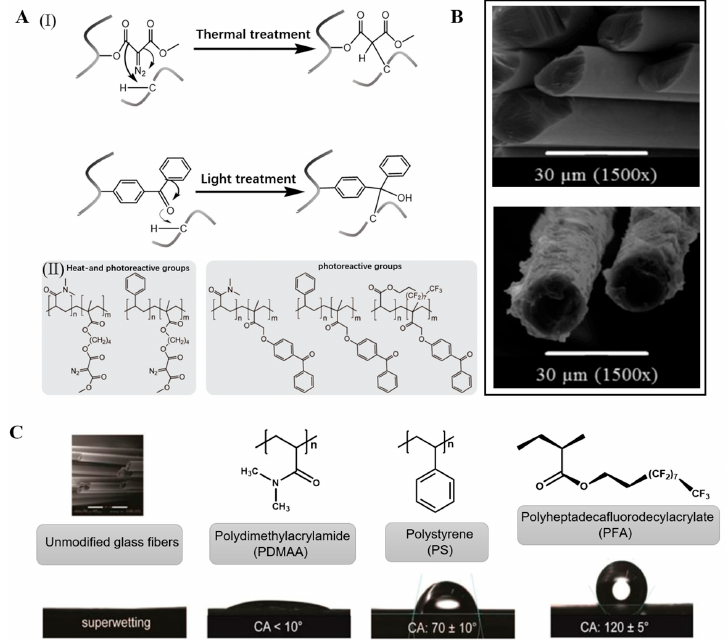
Figure 2. ( A ) ( I ) Schematic description of the mechanism of chemical modification of the fiber-matrix interface using adhesion accelerators. ( II ) Polymer systems selected as adhesion promoters containing diazacarbonyl ( left ) and benzophenone groups ( right ). ( B ) SEM of fiber-matrix interface. ( C ) Tailoring the wetting behavior of glass fibers upon coating with hydrophilic polymers and hydrophobic polymers. Reproduced with permission from reference [61]. Copyright 2019 Advanced Engineering Materials .